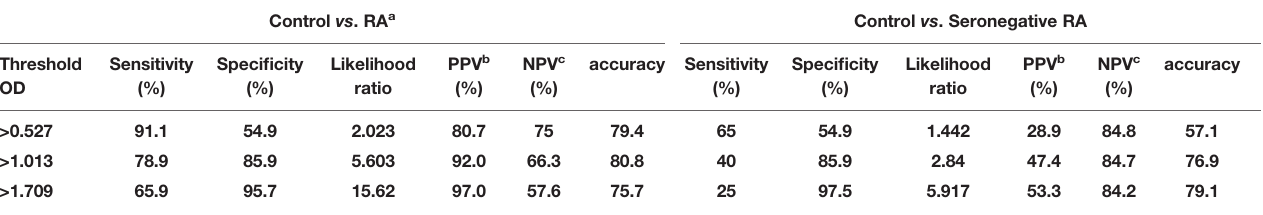
TABLE 2 | Receiver-operating characteristic curve analysis of the sensitivity, speci fi city, positive predictive value, negative predictive value, and accuracy for differentiating between healthy controls and rheumatoid arthritis patients according to circulating citrullinated fi lggrin level. Control vs . RA